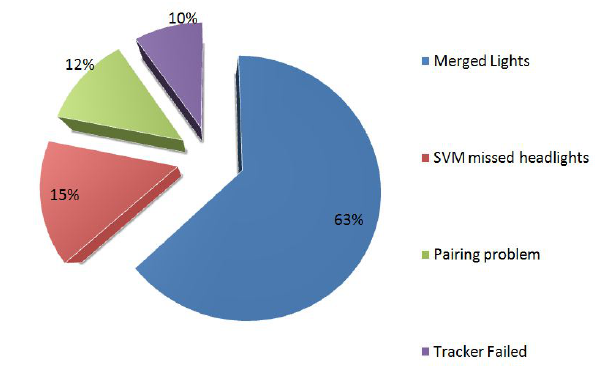
Figure 11. Failure analyses and error distribution.